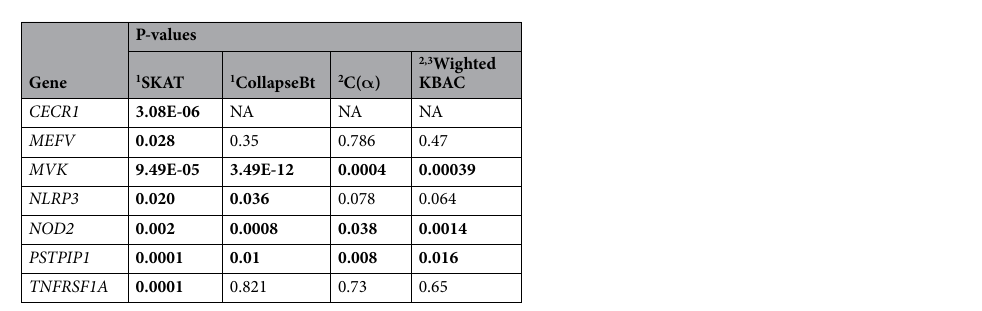
Table 2. Analysis of the association with BD of rare variants in seven genes related to AIDs. These tests analyze the association of rare variants (MAF < 0.05) grouped by gene. 1 Asymptotic and 2 permuted P-values. 3 Variants weighted by their Polyphen2 score. The P-values < 0.05 were considered significant and they are shown in bold. NA: Not available, the gene could not be